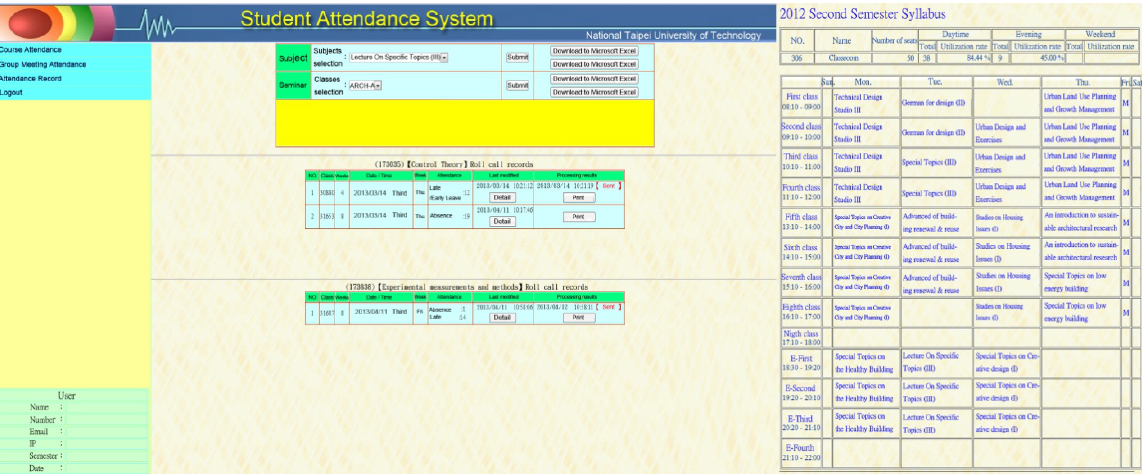
Figure 7. Special sensor interface—campus information